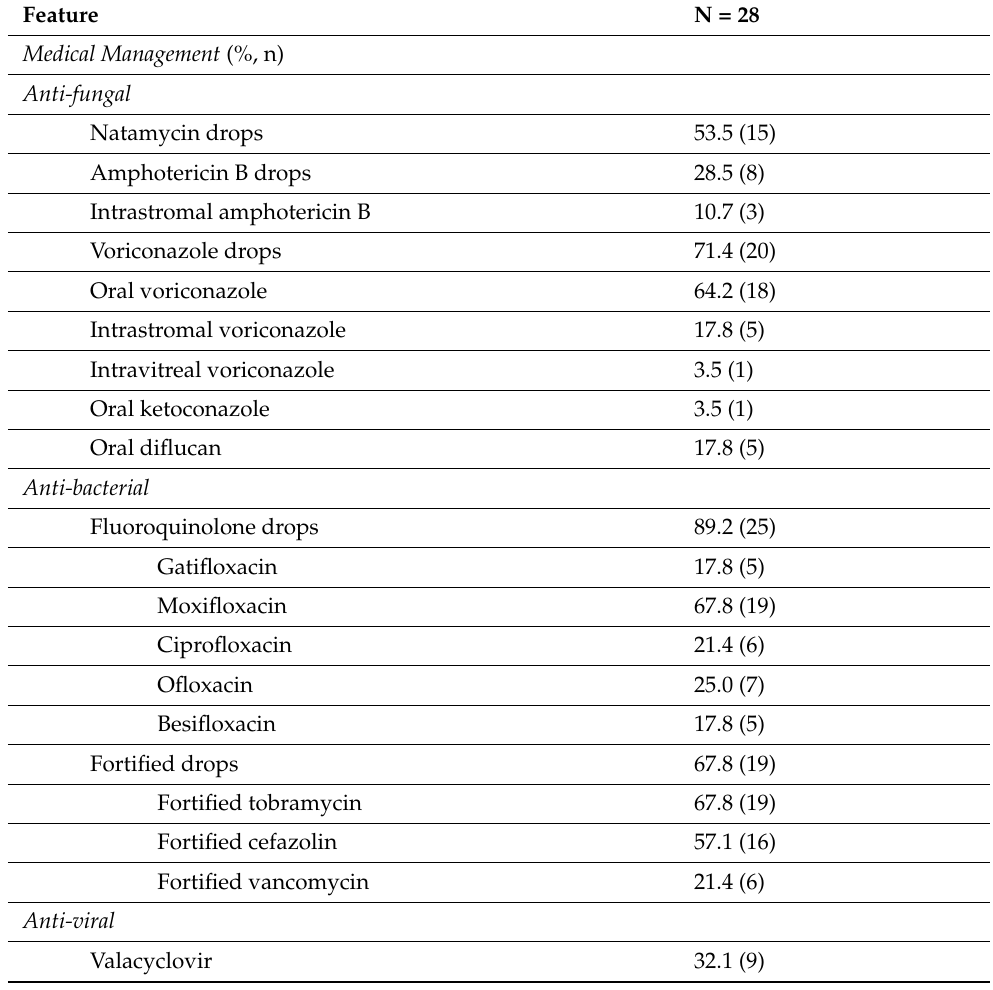
Table 2. Management and outcomes of patients with fungal